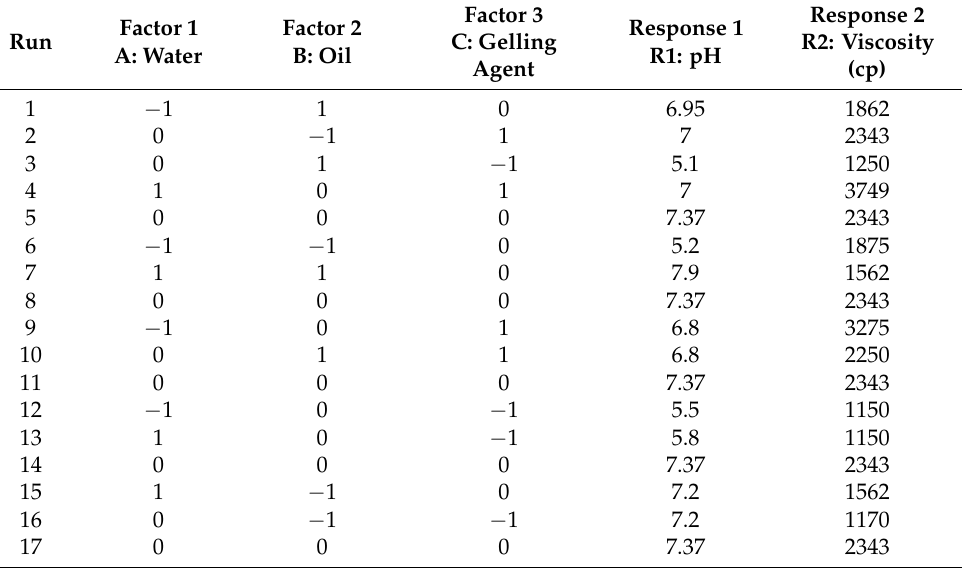
Table 4. Coded and uncoded level of the factors with their effects on responses (R1 and R2).